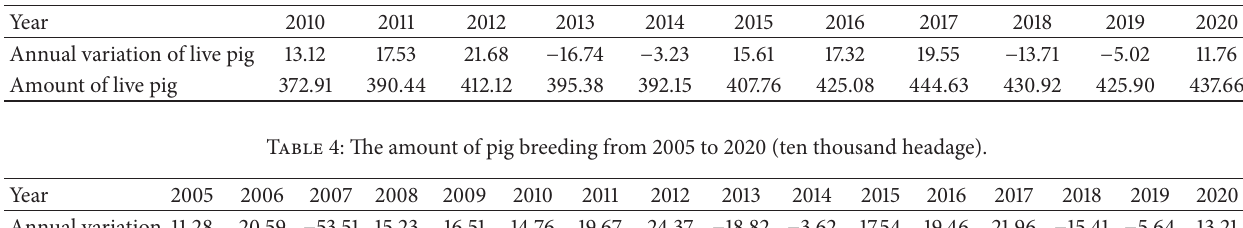
Table 3: The projected amount of live pig from 2010 to 2015 (ten thousand headage).